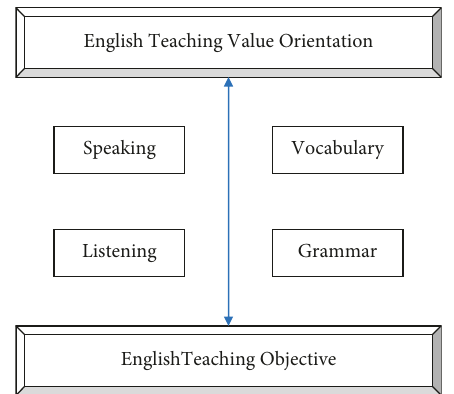
Figure 2: English teaching